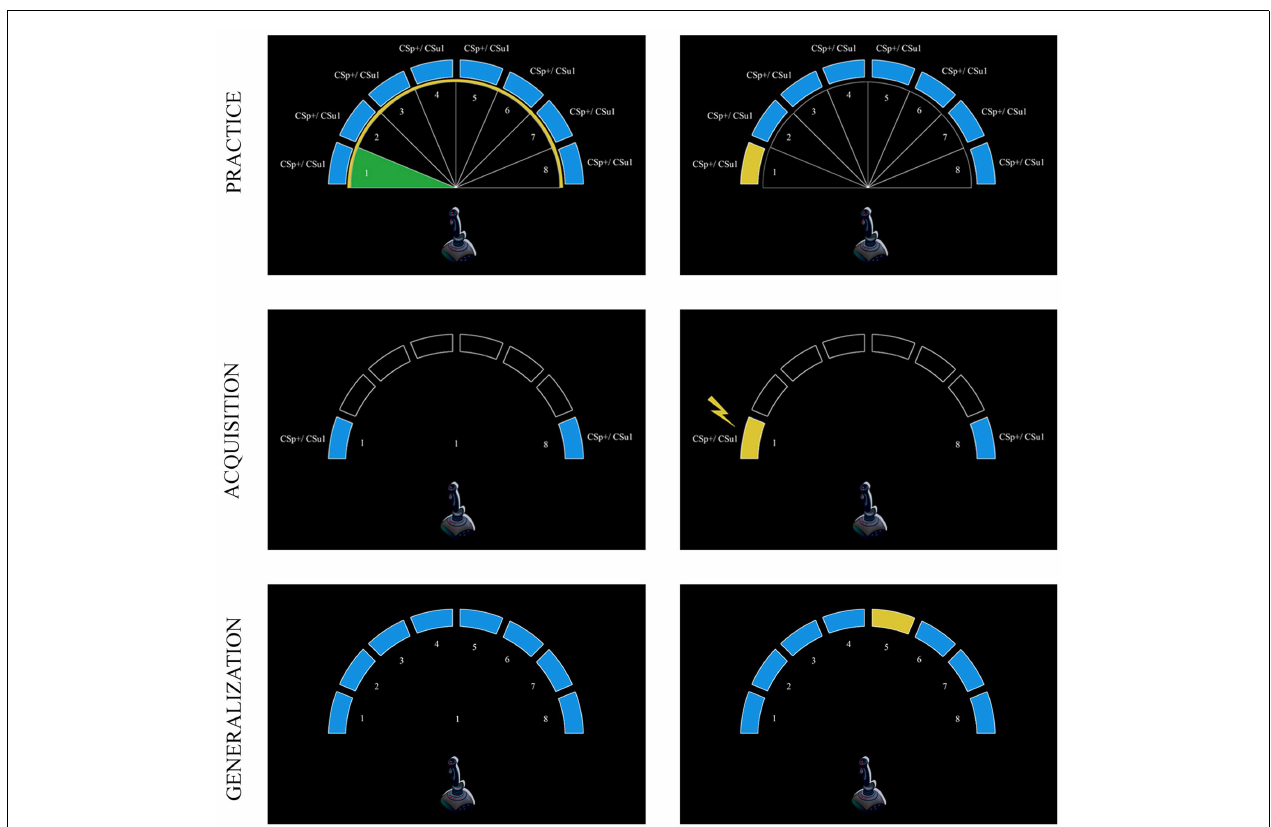
acquisition phase (middle panel), participants only carried out two movements (CSs). After “+” was presented in the middle of the screen, this was replaced by a number that indicated the movement direction (1 or 8). In the predictable group one of these movements was followed by a pain-US (CS p +, i.e., left) indicated by a lightning bolt, whereas the other movement (CS p − , i.e., right) was never followed by the pain-US. In the unpredictable group, movements (CS u 1/CS u 2) were never followed by the pain-US, but it was delivered during the ITI. Finally, during the generalization phase (lower panel) participants had to perform all movements (GSs and CSs) under extinction (i.e., none of the movements were followed by the